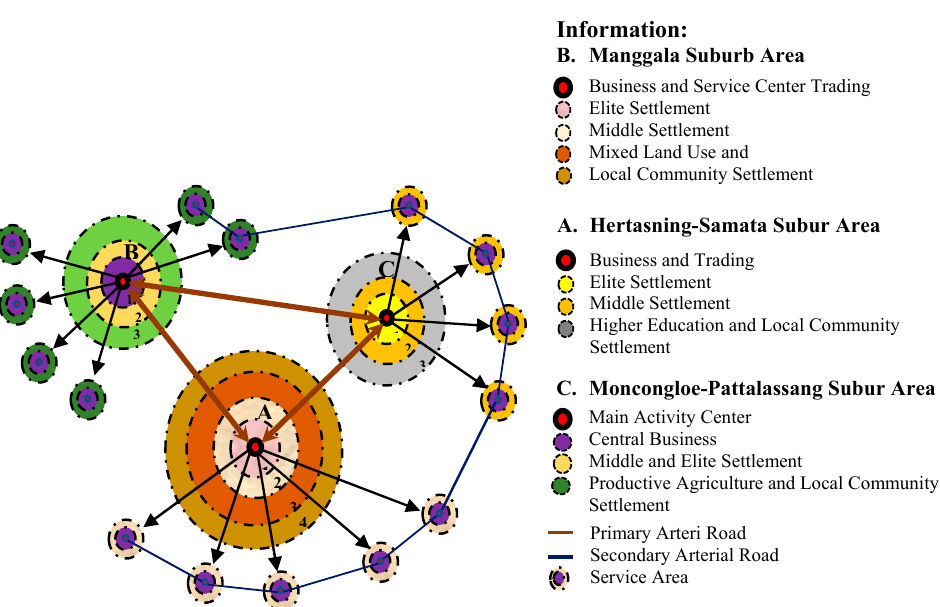
Figure 9. Mamminasata Metropolitan Suburbs Urban Service Centers. Source: author elaboration; Folder (c) 2019 Google. Folder © 2019 Google.